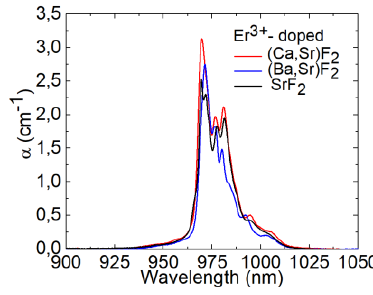
Fig. 3. Absorption spectra for the 4 I 15/2 → 4 I 11/2 transition of the Er:(M 1 ,M 2 )F 2 and Er:SrF 2 crystals